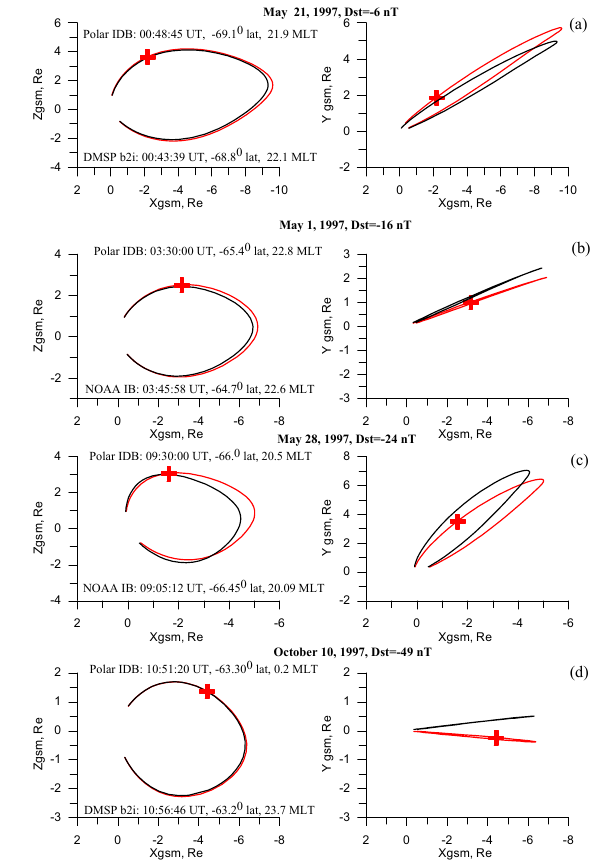
Fig. 4. Noon-midnight meridian (left panels) and equatorial plane (right panels) projections of the magnetic field lines correspond- ing to DMSP or NOAA (black lines) and Polar (red line) locations, when the conjugate boundaries were observed at Polar and DMSP on ( a ) 21 May 1997 and ( d ) 10 October 1997, and at Polar and NOAA on ( b ) 1 May 1997 and ( c ) 28 May 1997. The thick red cross shows the Polar